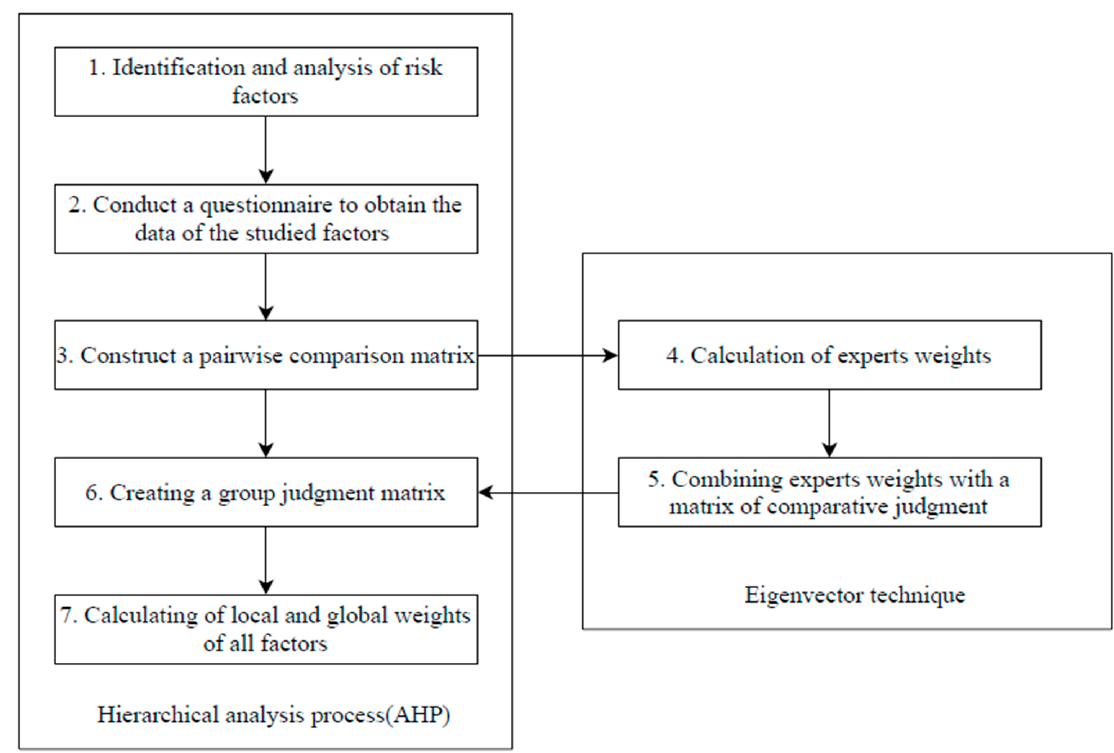
Figure 3. Algorithm of analysis of hierarchical process AHP [2, 25 ].